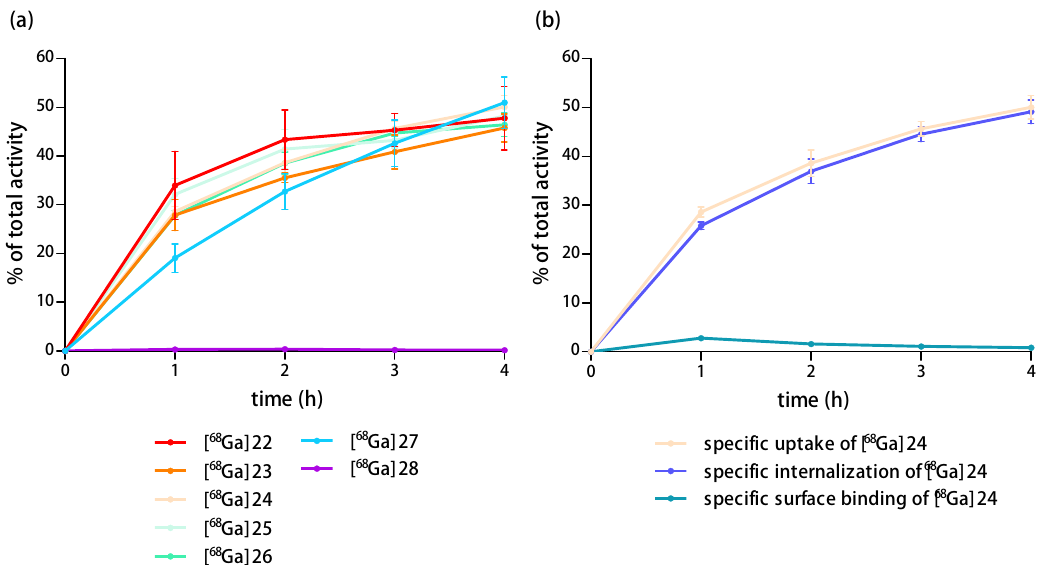
Figure 7. ( a ) Specific cell uptake of [ 68 Ga] 22 − [ 68 Ga] 26 , [ 68 Ga] 27 and [ 68 Ga] 28 in T-47D cells over 4 h of incubation; ( b ) Uptake of [ 68 Ga] 24 in the same cells, differentiated by overall uptake, internalization, and surface binding.